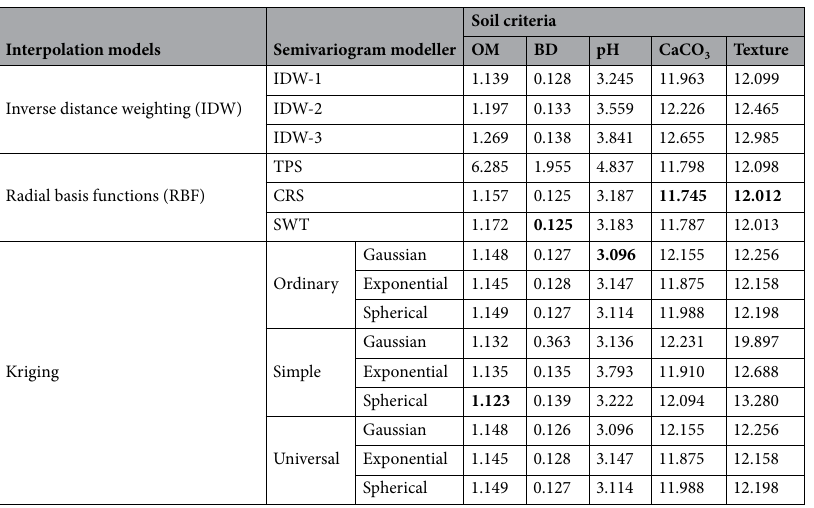
Table 6. Interpolation models and RMSE of soil criteria. TPS thin plate spline, CRS completely regularized spline, SWT spline with tension, OM organic matter, BD bulk density.